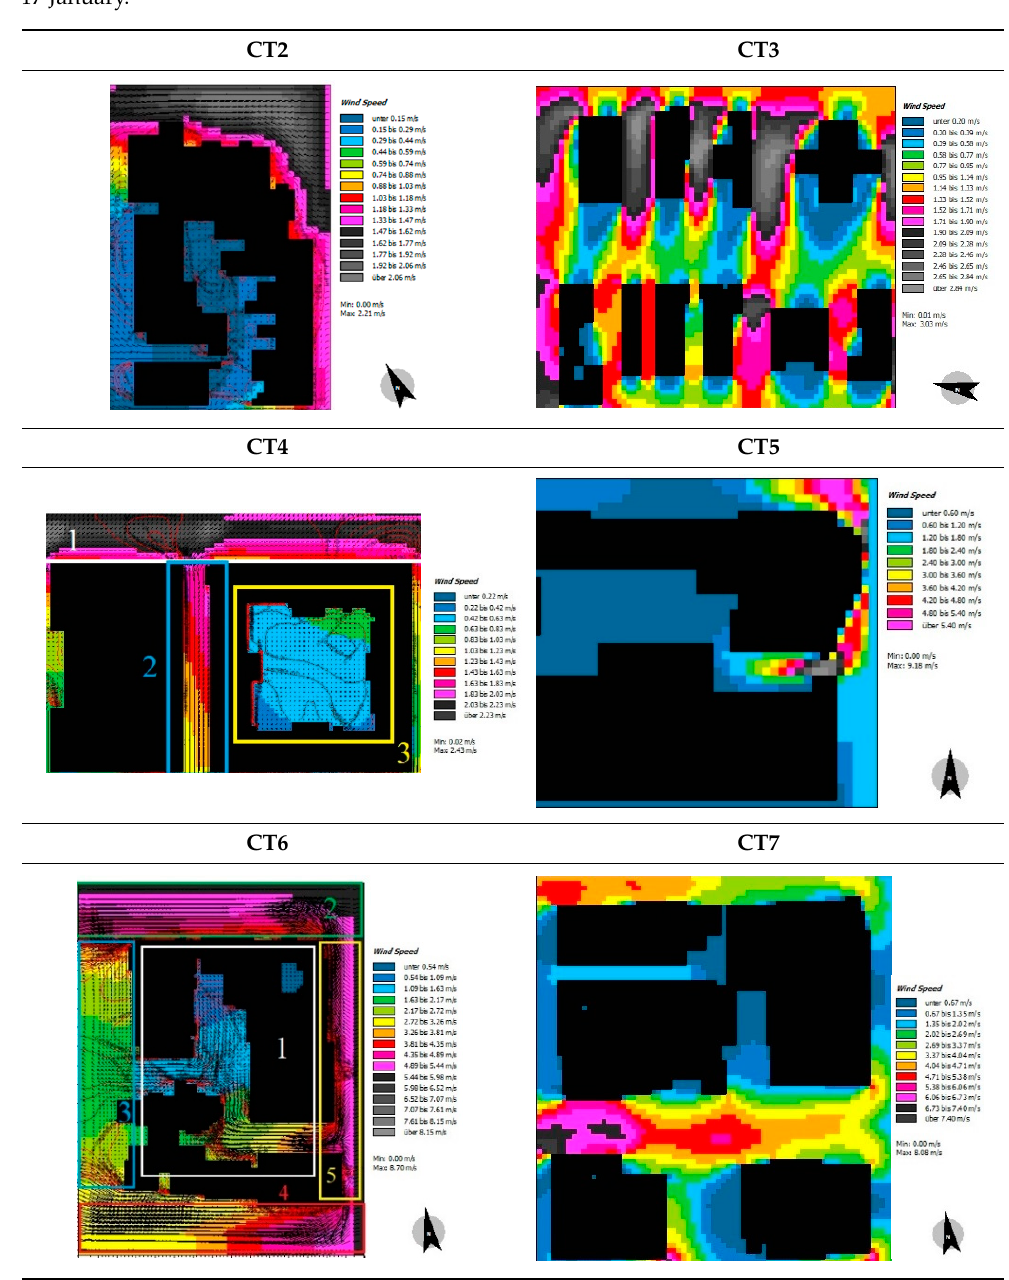
Table 9. Summary of wind speed/direction distribution map across compact-type arrangements on